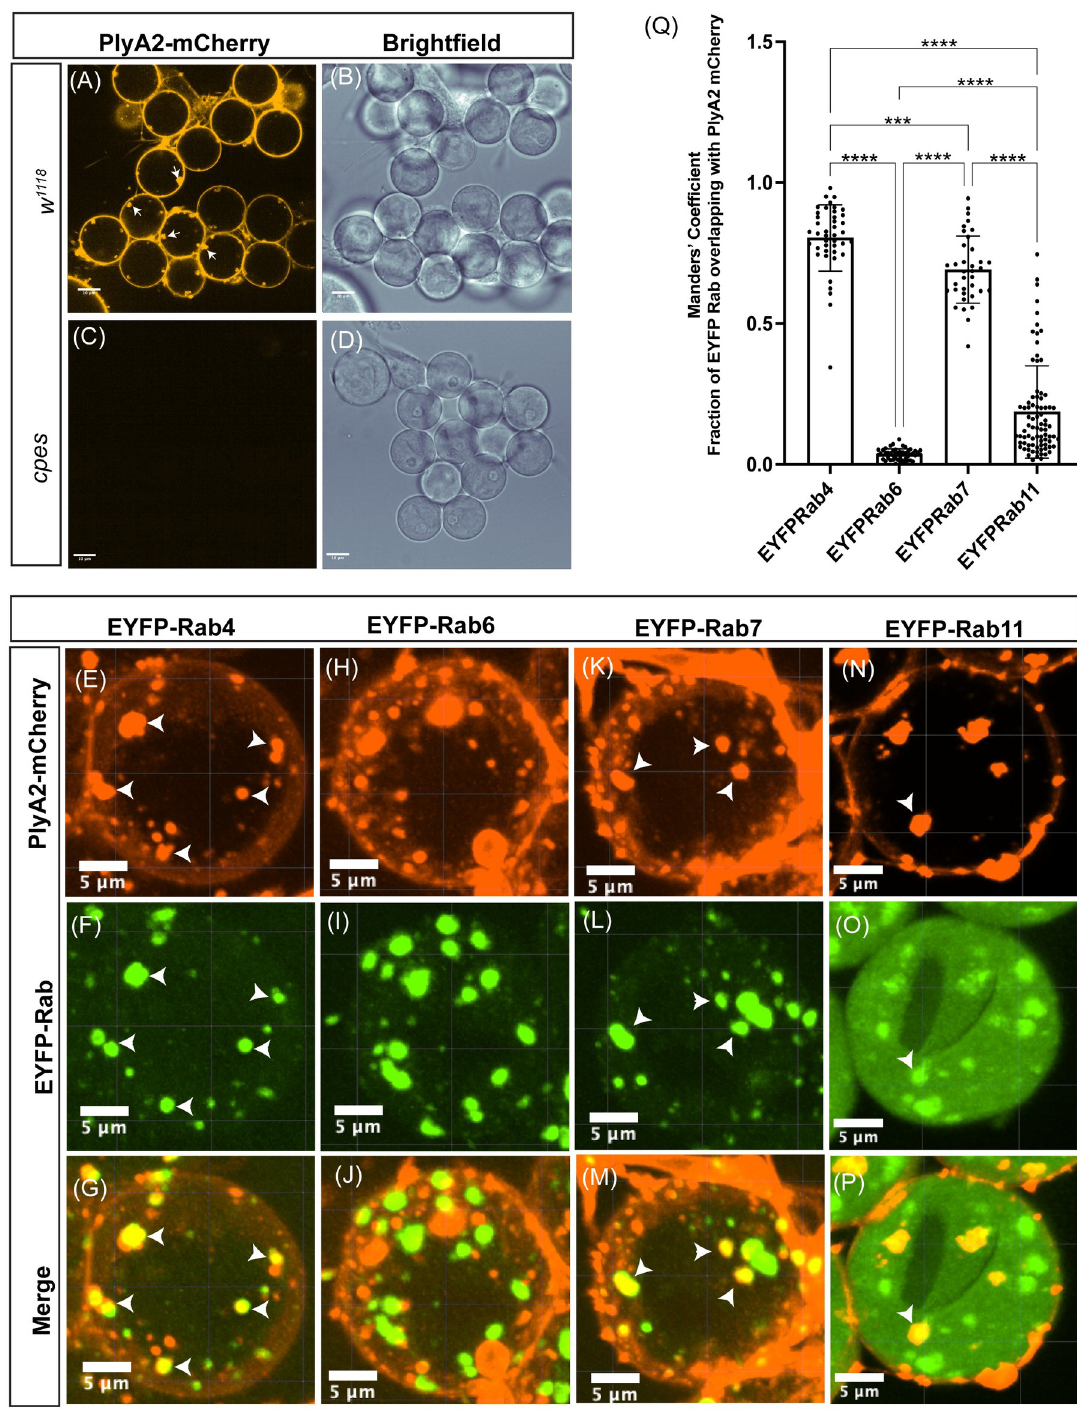
Fig 5. CPE localizes to plasma membrane and endosomes. (A–D) Live spermatocytes were incubated with purified PlyA2-mCherry (10 μ g/ml) for 30 min followed by washes with M3 insect media (2 × ) and imaged using spinning disk confocal microscopy. (A and B) w 1118 spermatocytes, (C and D) cpes spermatocytes. (E–P) Live spermatocytes expressing endogenous EYFP tagged Rab proteins were incubated with PlyA2-mCherry for 1 h followed by washes with M3 insect media (2 × ) and imaged using spinning disk confocal microscopy. (E–G) EYFP-Rab4 spermatocytes, (H–J) EYFP-Rab6 spermatocytes, (K–M) EYFP-Rab7 spermatocytes, (N–P) EYFP-Rab11 spermatocytes. Arrowheads indicate colocalizing structures. (Q) Colocalization coefficient (Mander’s coefficient) measurements showing fraction of EYFP Rab proteins colocalize with internalized PlyA2-mCherry. Mander’s coefficient was determined using